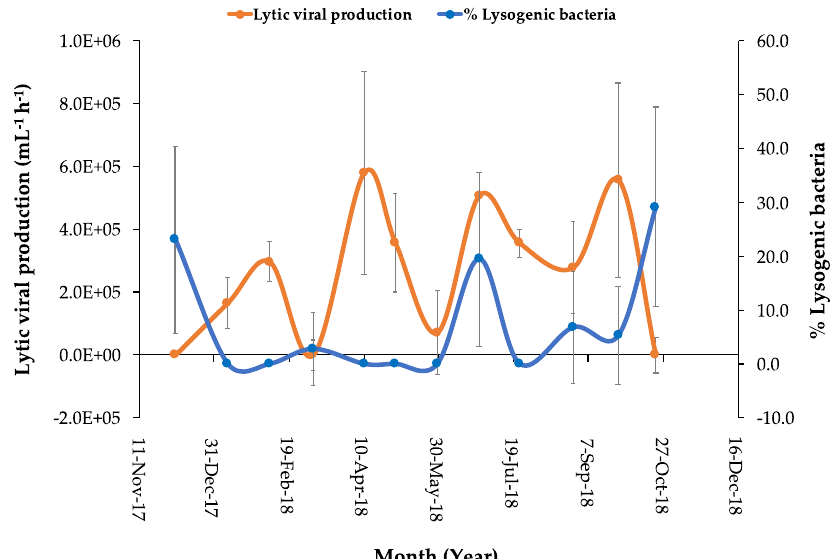
Figure 6. Lytic viral production (LVP) (orange line and dots) and percentages of lysogenic bacteria (blue line and dots) during the incubation experiments from December 2017 to October 2018. The vertical bars encompassed the error bars.